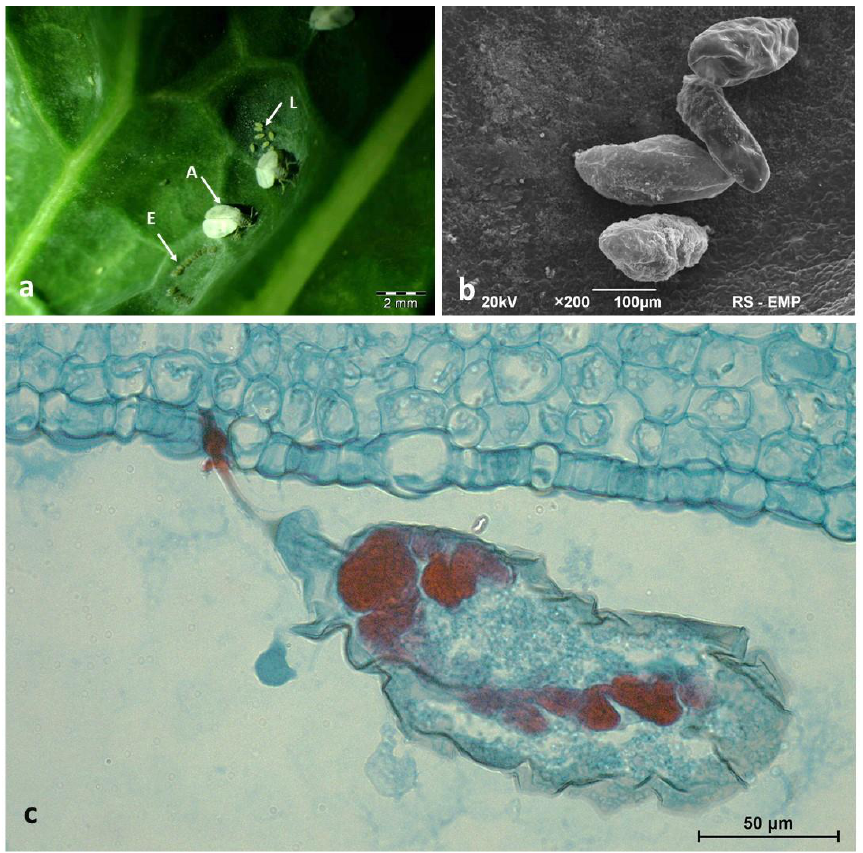
Figure 2. Cabbage whitefly ( Aleyrodes proletella ) on the underside of the leaves of savoy cabbage. ( a ) Adult forms (A), eggs (E), and larvae (L) in the stereoscope microscope, ( b ) Larvae in SEM, ( c ) Adult form of A. proletella inserting its mandibular stylet in the leaf epidermis. Cross-section of leaf stained with safranin-fast green and imaged with Light microscopy (LM).